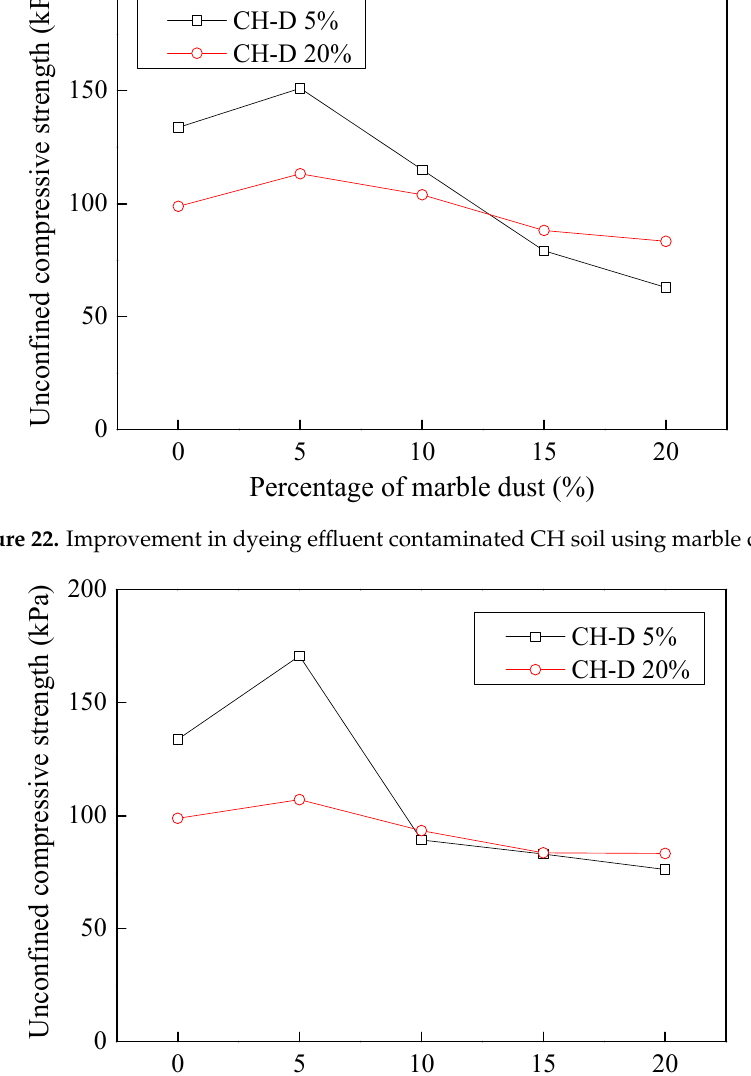
Percentage of marble dust (%) CL-T 5% CL-T 20% Figure 21. Improvement of tannery effluent contaminated CL soil using marble dust. 3.9.3. Stabilization of Dyeing ‐ Affected CH Soil Figure 22 displays the trends observed when different percentages of marble dust were added to acid ‐ affected CH soil. With an increase in marble dust concentration, unconfined compressive strength decreased rapidly from 133.69 kPa to 62.88 kPa at 5% acid contamination. At 20% acid contamination, it decreased from 98.81 kPa to 83.29 kPa when marble dust concentration reached